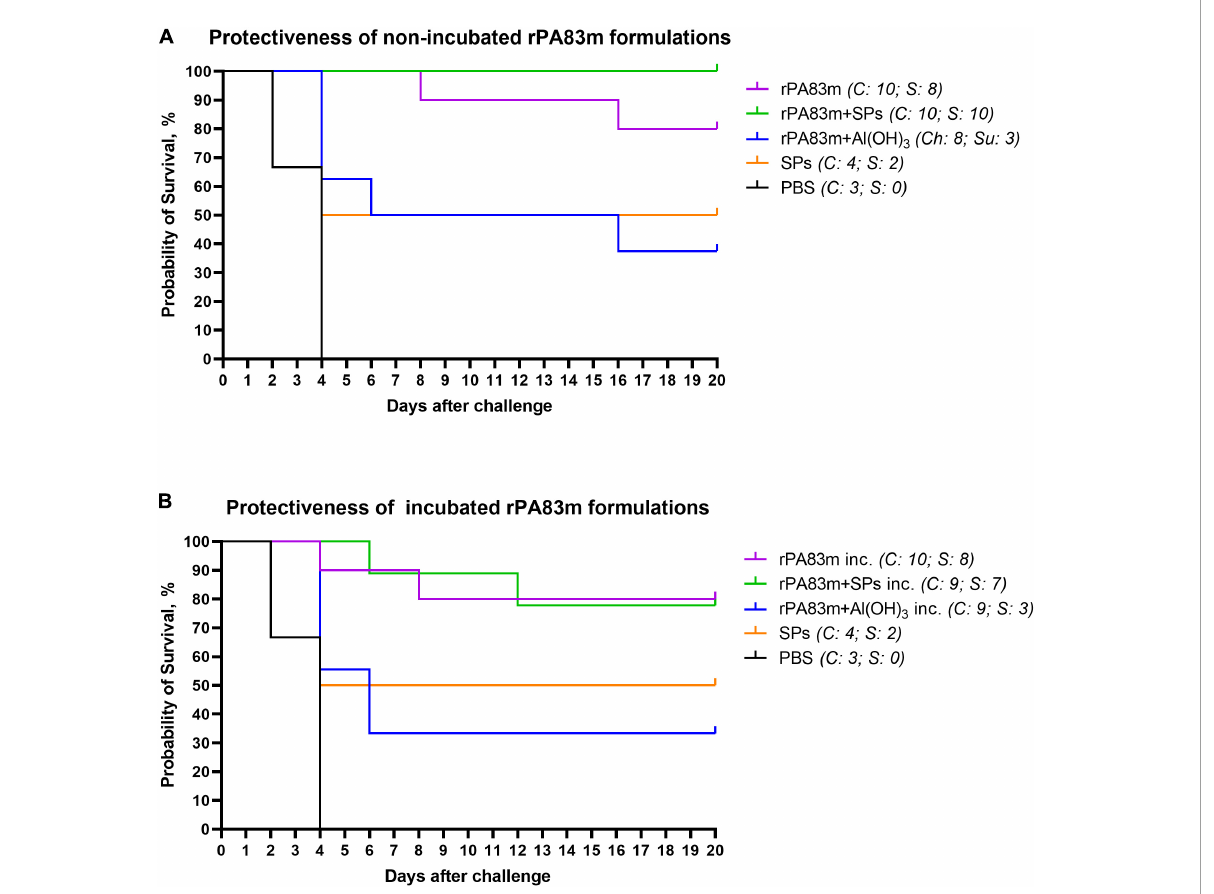
FIGURE7 Protectiveness of rPA83m formulations in guinea pigs after second B. anthracis strain 81/1 anthrax spore challenge. (A) Protectiveness of non-incubated rPA83m formulations. Figure represents survival curves of guinea pig groups immunised with non-incubated formulations of rPA83m ( n = 10), rPA83m + SPs ( n = 10), rPA83 + Al(OH) 3 ( n = 8), SPs ( n = 4) or PBS ( n = 3). (B) Protectiveness of non-incubated rPA83m formulations. Figure represents survival curves of guinea pig groups immunised with rPA83m inc. ( n = 10), rPA83m + SPs inc. ( n = 9), rPA83 + Al(OH) 3 inc. ( n = 9), SPs ( n = 4), or PBS ( n = 3). Incubated formulations marked with “inc.” were incubated at +37 ◦ C for 27 days. Groups of guinea pigs ( n = 10 for groups immunised with rPA83m formulations, n = 5 for control groups immunised with SPs or PBS) were